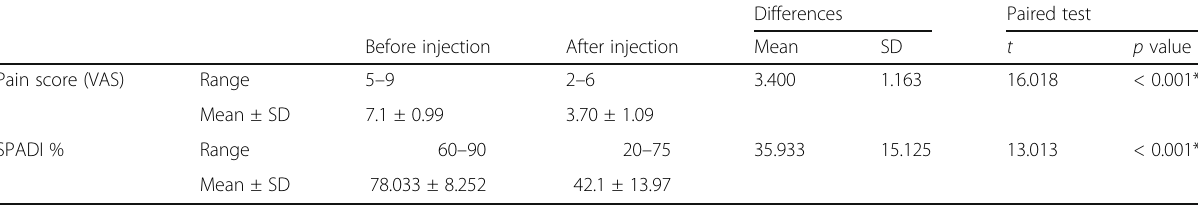
Table 3 Comparison between VAS score and SPADI before and after injection Differences Paired test Before injection After injection Mean